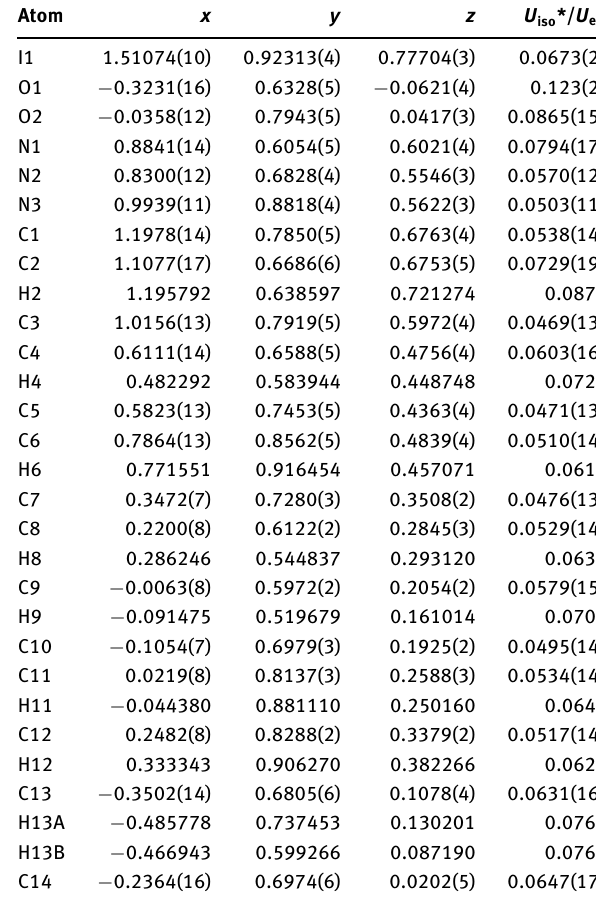
Table 2: Fractional atomic coordinates and isotropic or equivalent isotropic displacement parameters (Å 2